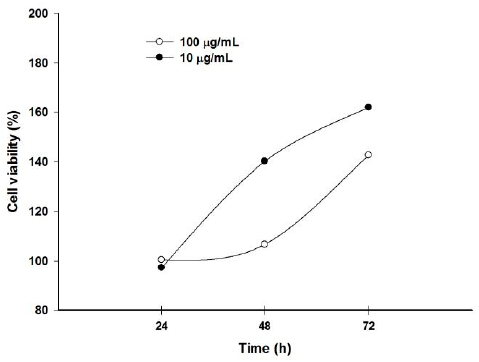
Figure 4. Testosterone significantly induced keratinocyte over-proliferation in a dose- and time-dependent manner.